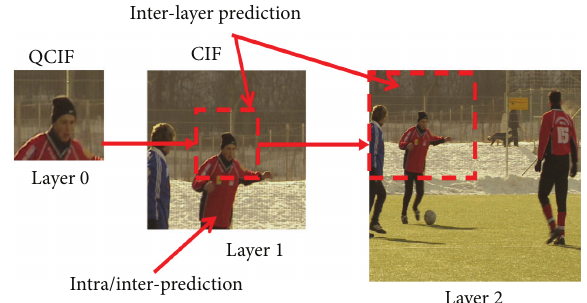
Figure 3: Example of the ROI dynamic adjustment and scalability (e.g., for mobile devices with different spatial resolution) by using a cropping